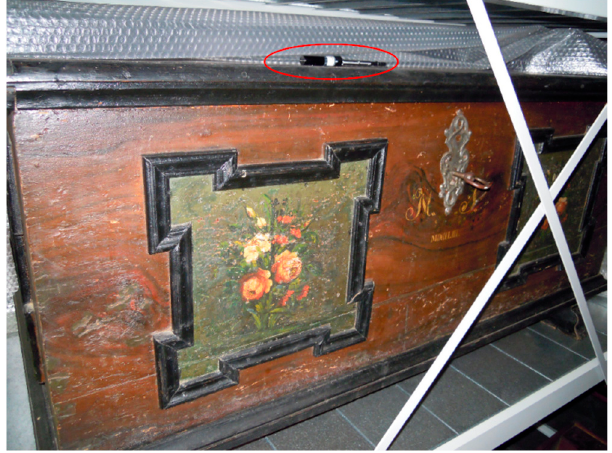
Figure 7. In situ HS SPME sampling of OBJ4, the SPME holder circled in red. Figure 7. Museum depot air HS SPME sampling location No. 1, the SPME holder circled in